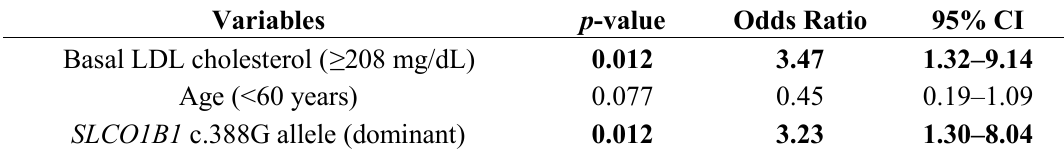
Table 3. Multiple logistic regression analysis for reduction of LDL cholesterol after atorvastatin